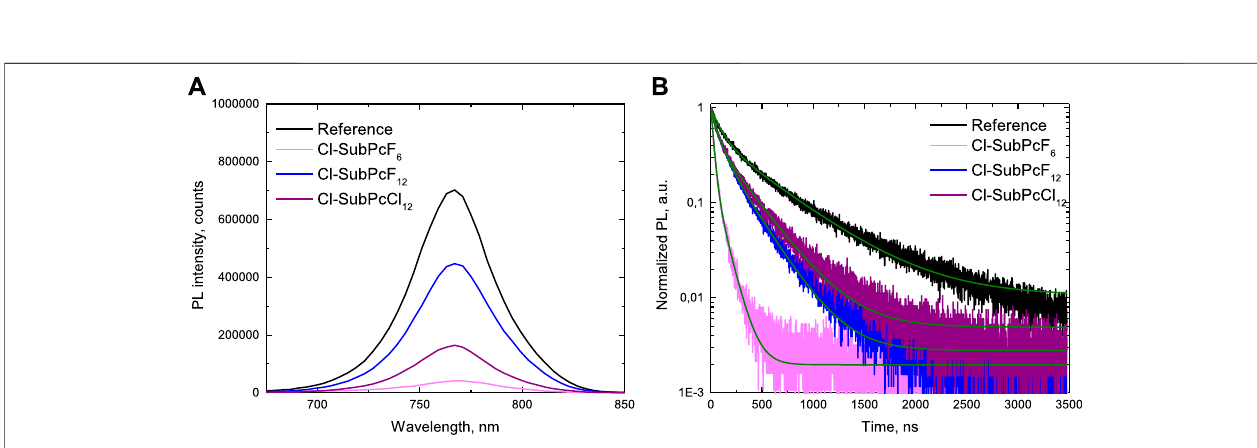
FIGURE4| PhotoluminescencepropertiesofPVKand PVK/SubPc samplesdeposited on glass: (A) PLspectra( λ exc =450 nm)and (B) time-resolved PLspectra ( λ exc = 640 nm, λ em = 780